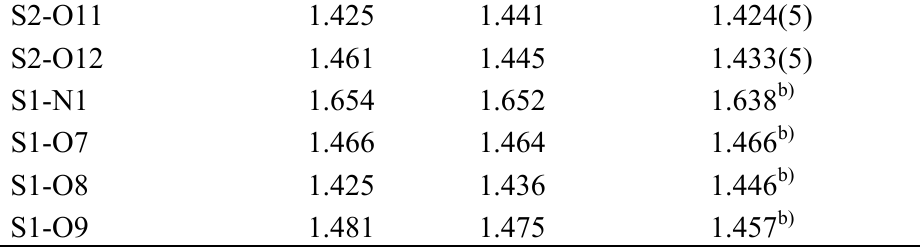
Table 2. Selected optimized and experimental bond angles for GlcN,6-SO